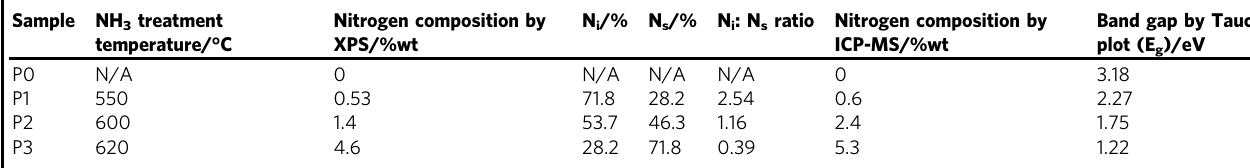
Table 1 Nitrogen concentration in P25 samples by XPS and ICP-MS; substitutional nitrogen (N s ) and interstitial nitrogen (N i ) in